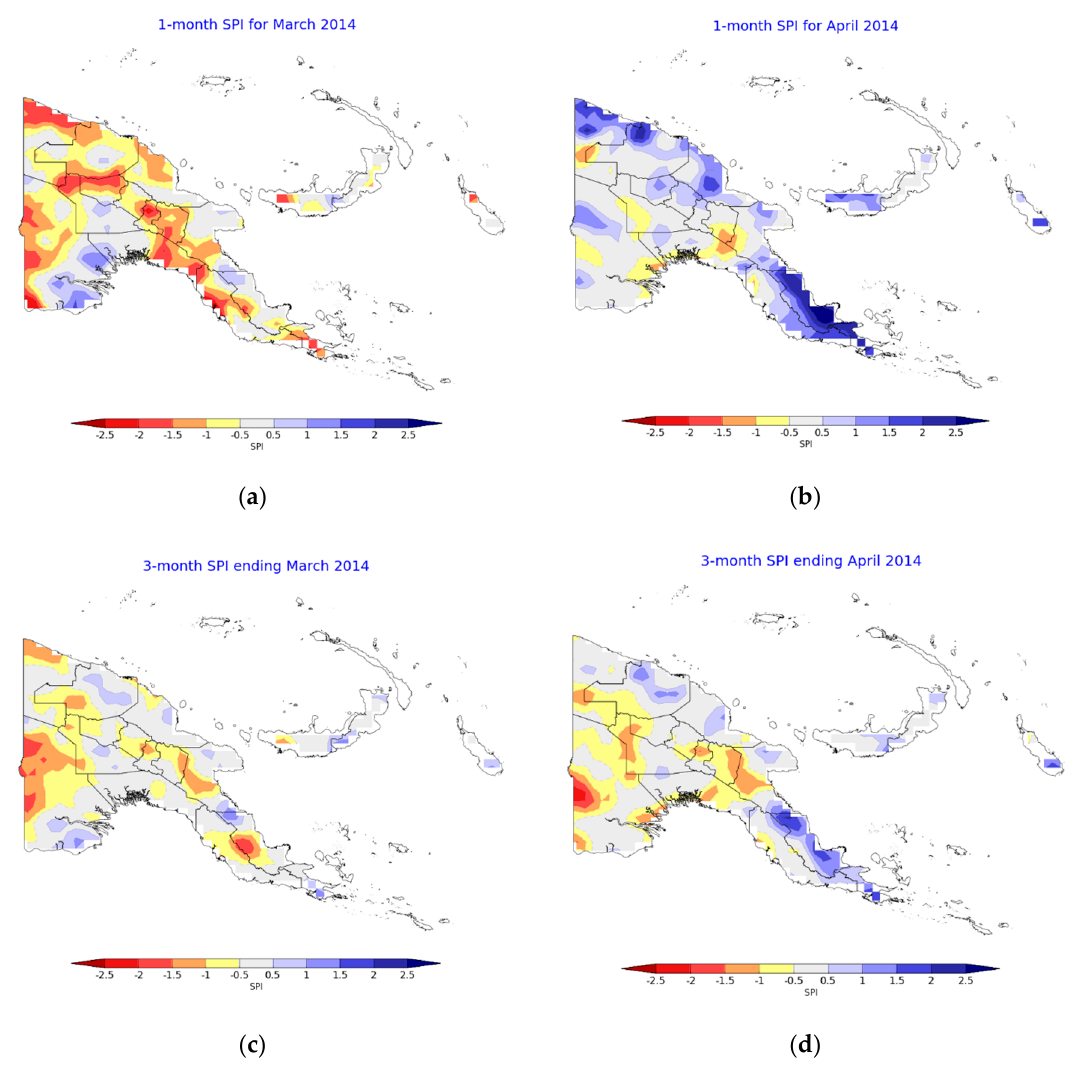
Figure 9. Comparison of 3-month and 1-month Standardized Precipitation Index (SPI) for March and April 2014. ( a ) 1-month SPI for March 2014; ( b ) 1-month SPI for April 2014; ( c ) 3-month SPI for March 2014; ( d ) 3-month SPI for April 2014.